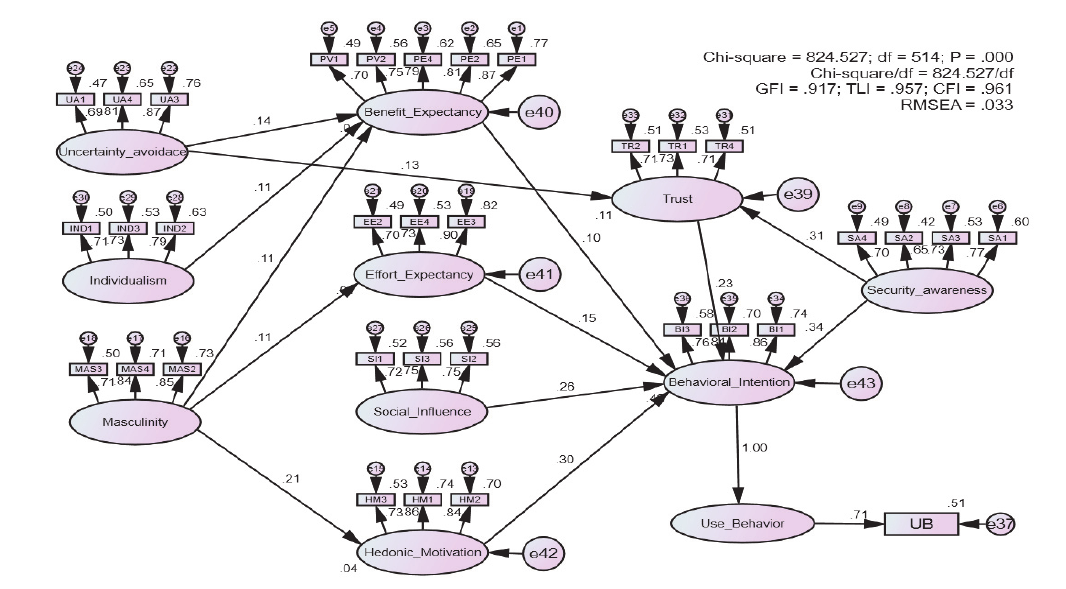
Fig. 2. Results of the second SEM structure Estimate*